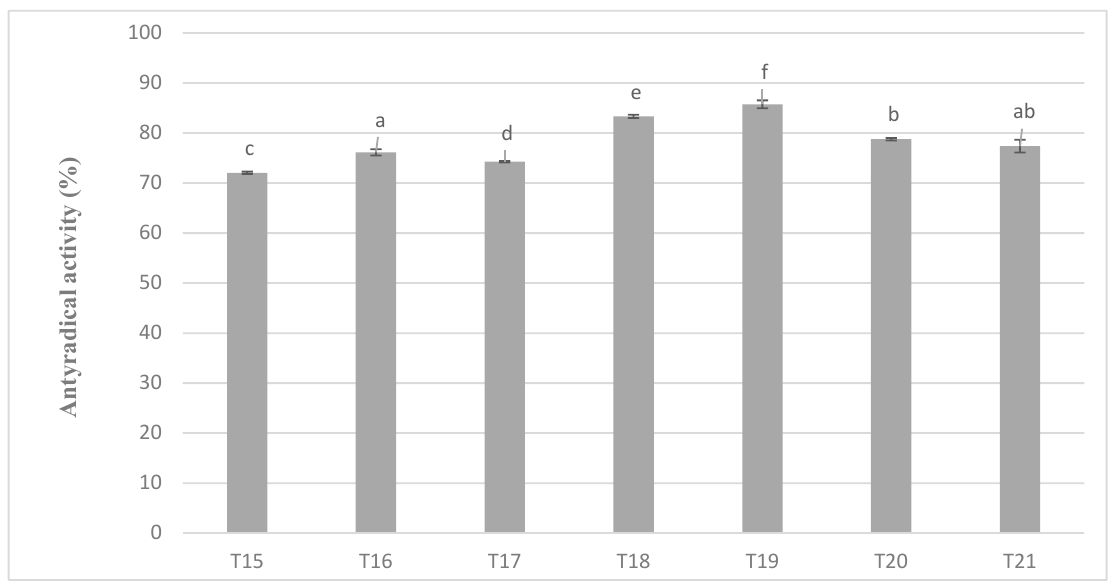
Figure 6. Antioxidant activity in chocolate milk masses prepared from cocoa liquor from Ghana (the same letter means that there are no statistically significant differences between the analyzed products at a confidence level of α = 0.05; the abbreviations used in the graph are described in Table 3).